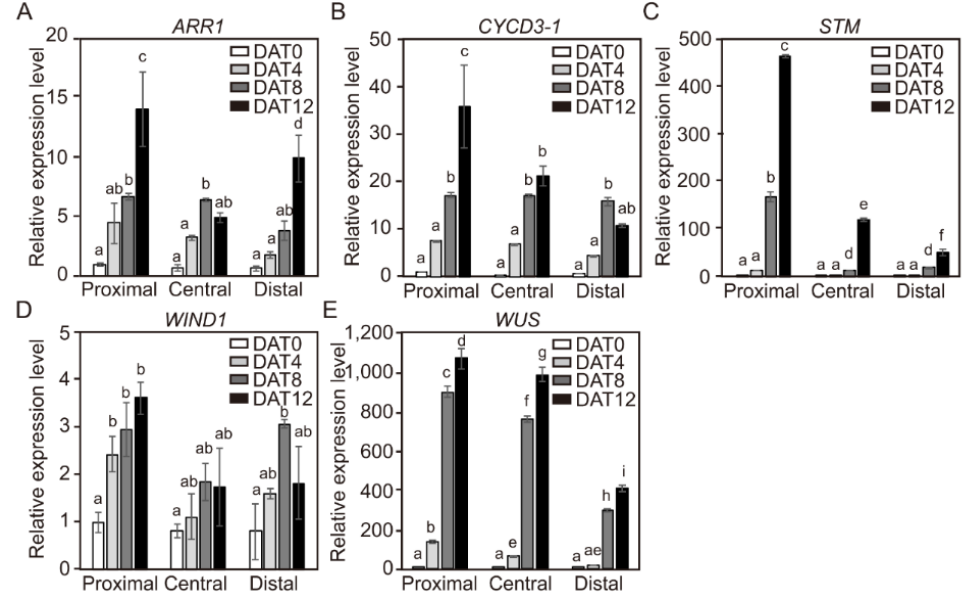
Figure 8. The relative expression levels of CYCD3-1 and shoot regeneration regulatory genes in cotyledon explants in di ff erent positions for DAG4 seedlings during incubation. Relative gene expression level of ARR1 ( A ), CYCD3-1 ( B ), STM ( C ), WIND1 ( D ), and WUS ( E ) in three positions of DAG4 seedling cotyledon explants. Data are representative of the results from three independent experiments. Error bars represent SD ( n = 3). Di ff erent letters on the bars indicate significant di ff erences between each treatment (ANOVA followed by a Tukey’s test, p < 0.05). DAG = Day after germination; DAT = day after treatment.